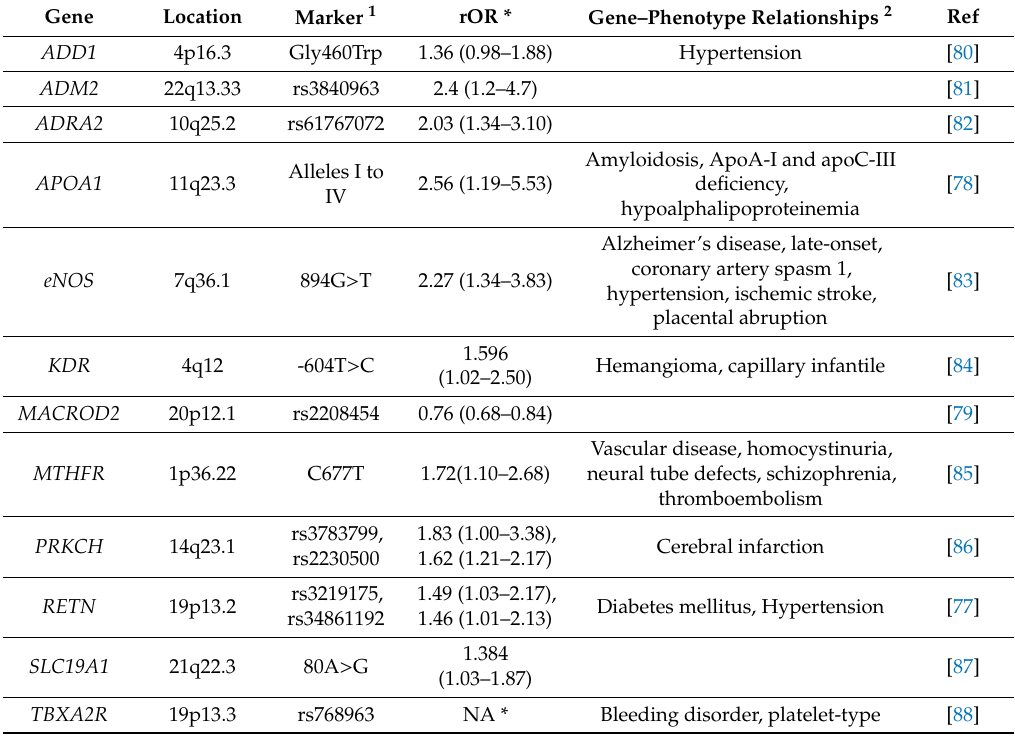
Table 5. Genes Associated both to Covert Infarcts and